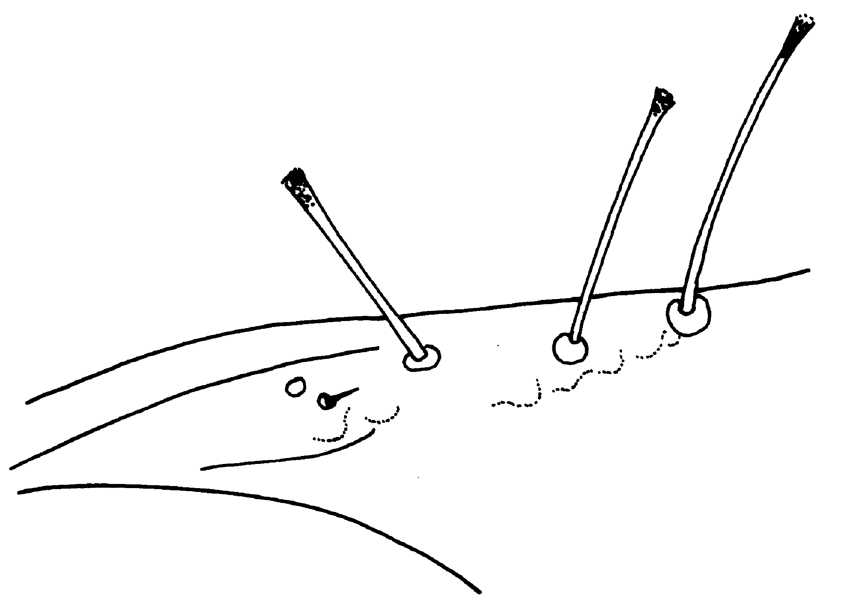
Figures 6. Haplothrips shivendraii sp. n.: part of fore wing,